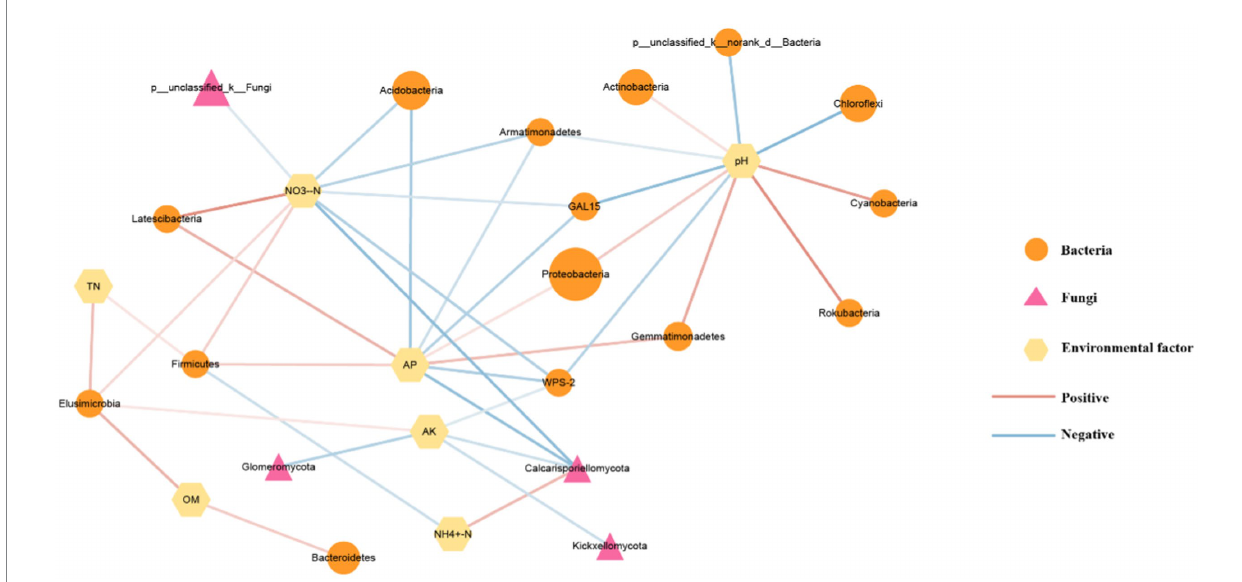
FIGURE 8 Correlation analysis of genusphylumate level microorganisms with environmental factors and functional prediction pathways. The graph size represents the relative abundance values of microorganisms, with the red line showing a positive correlation and the blue line showing a negative